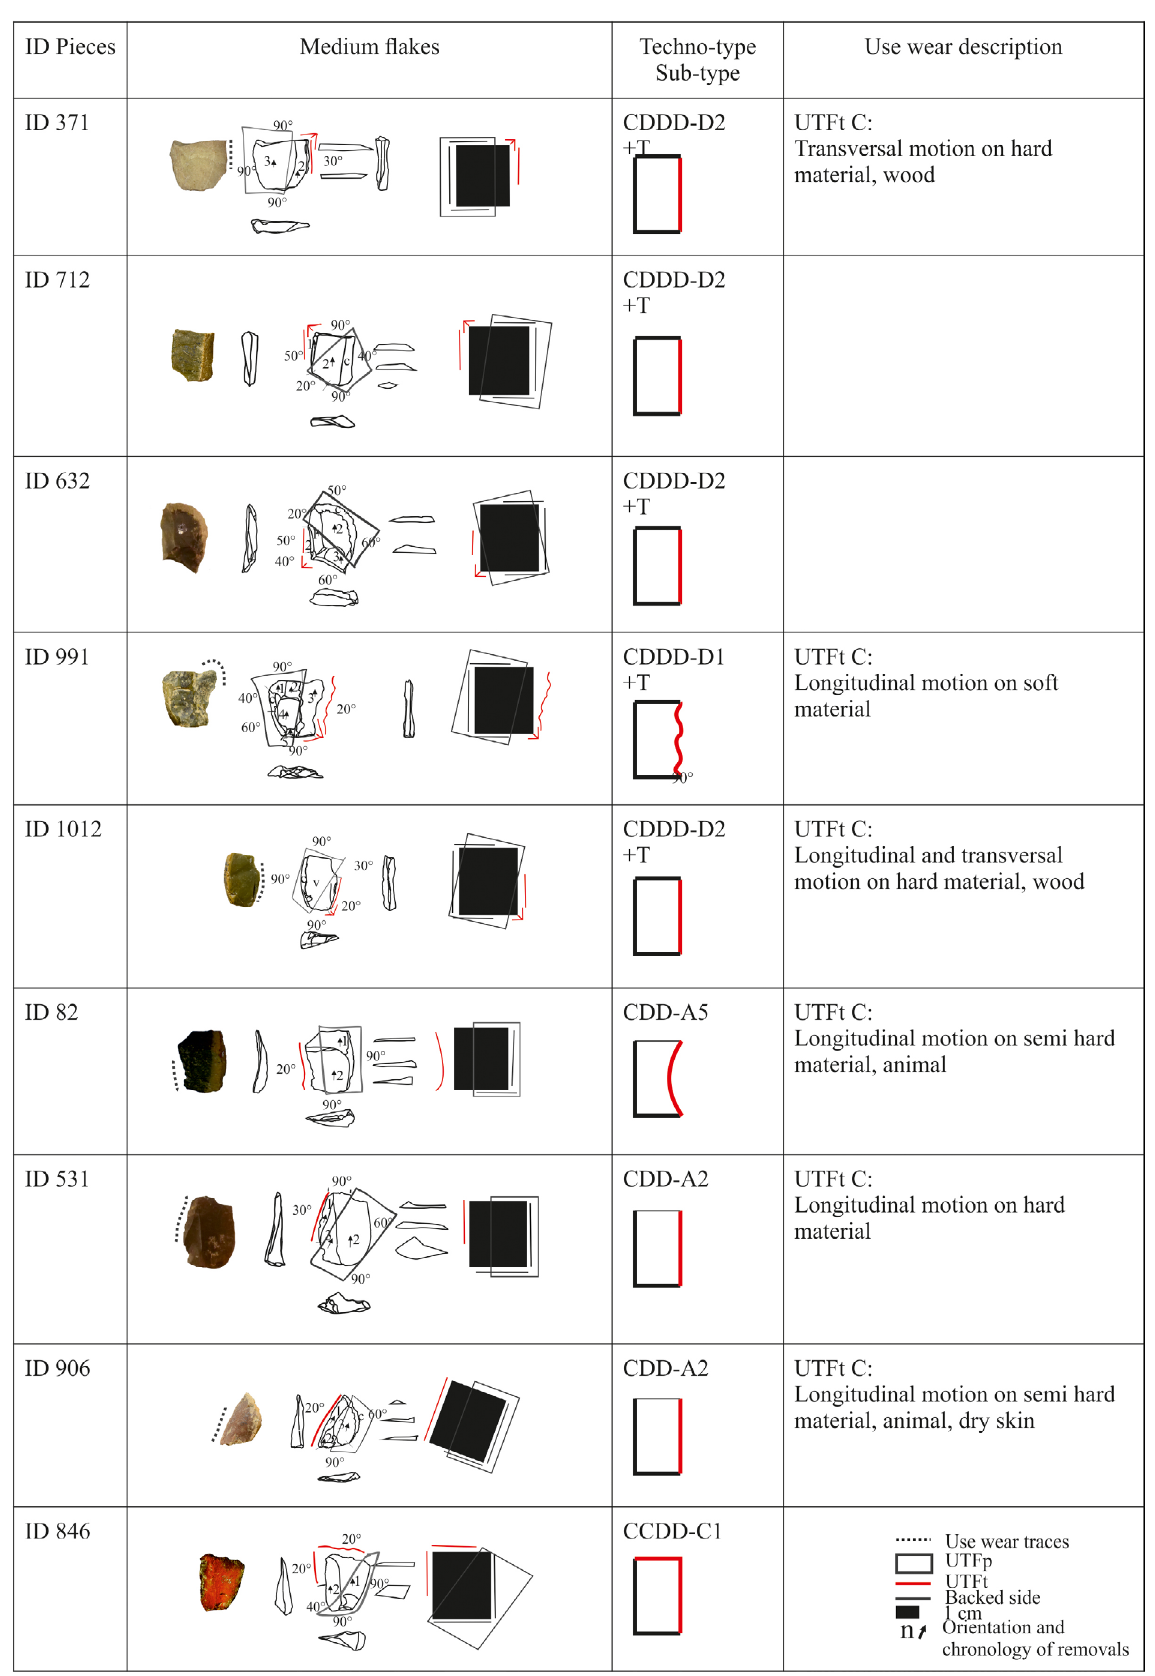
Figure 13. Techno-functional analysis and description of use wear traces of the medium